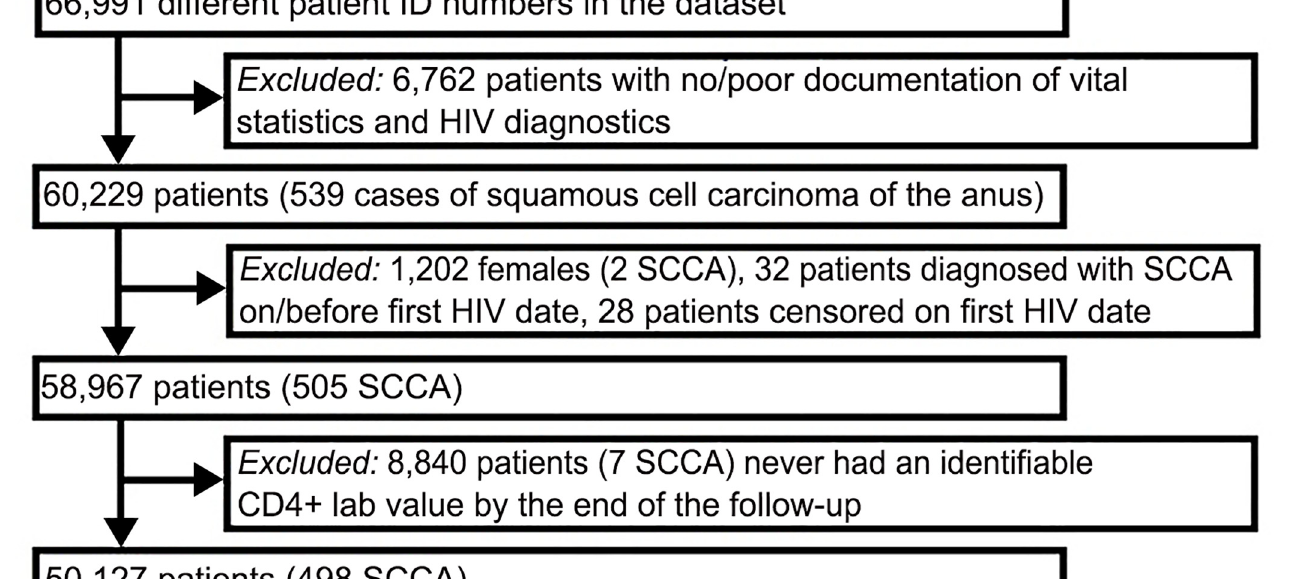
Fig 1. Flow Chart of Selected Criteria To Generate Final Cohort of HIV-infected Veterans.